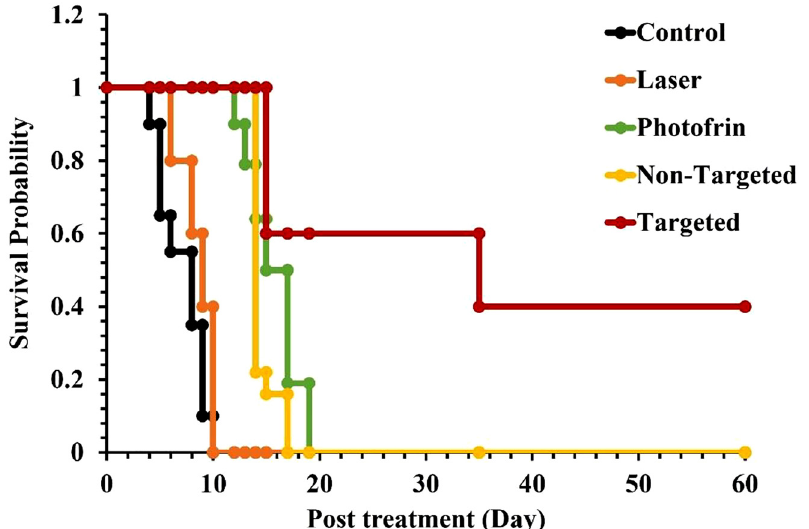
Figure 27: Survival curves for animals bearing a brain tumor: untreated (control), laser only, Photofrin ® + laser, nontargeted NPs + laserandF3-targetedNPs + laserwith a concentration of 7 mg Kg − 1 (Photofrin